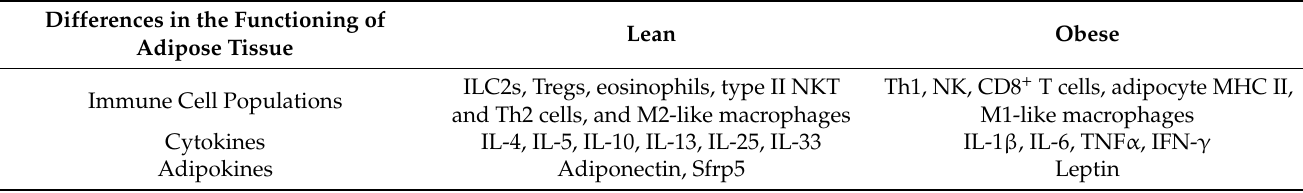
Table 2. Differences in the functioning of the adipose tissue in obese and lean subjects [58]. Differences in the Functioning of Lean Obese Adipose Tissue Th1, NK, CD8 + T cells, adipocyte MHC II, ILC2s, Tregs, eosinophils, type II NKT Immune Cell Populations M1-like macrophages and Th2 cells, and M2-like macrophages Cytokines Adipokines Adiponectin,